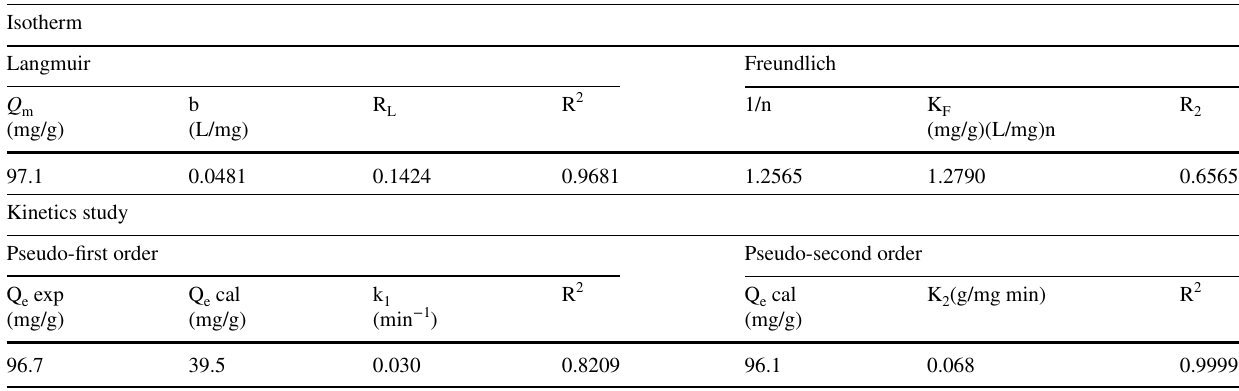
3 PO 4 -600 2:3 according to Isotherm and kinetic models